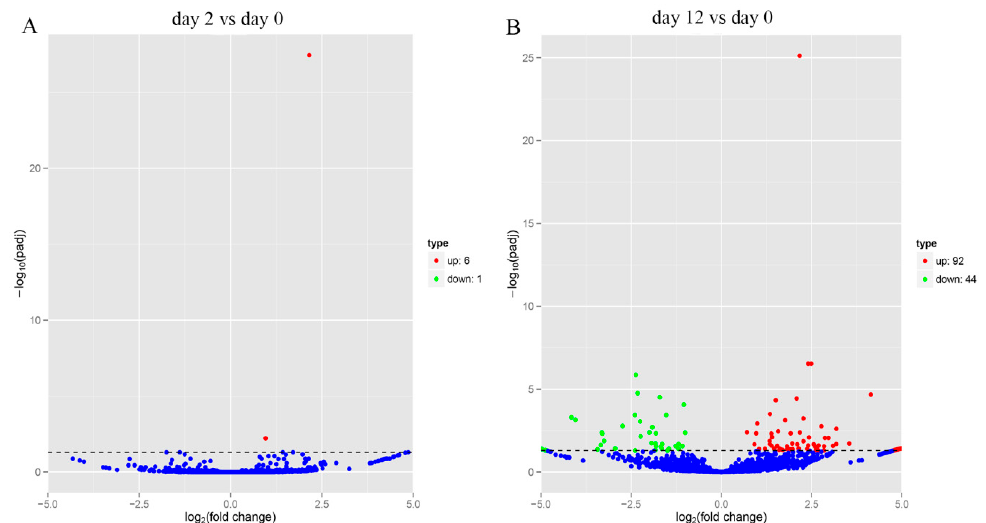
Figure 4. Differential expression analysis of circRNAs. ( A ) Volcano map of differentially expressed circRNAs between yak adipocyte differentiation at day 0 and day 2. ( B ) Volcano map of differentially expressed circRNAs between yak adipocyte differentiation at day 0 and day 12.